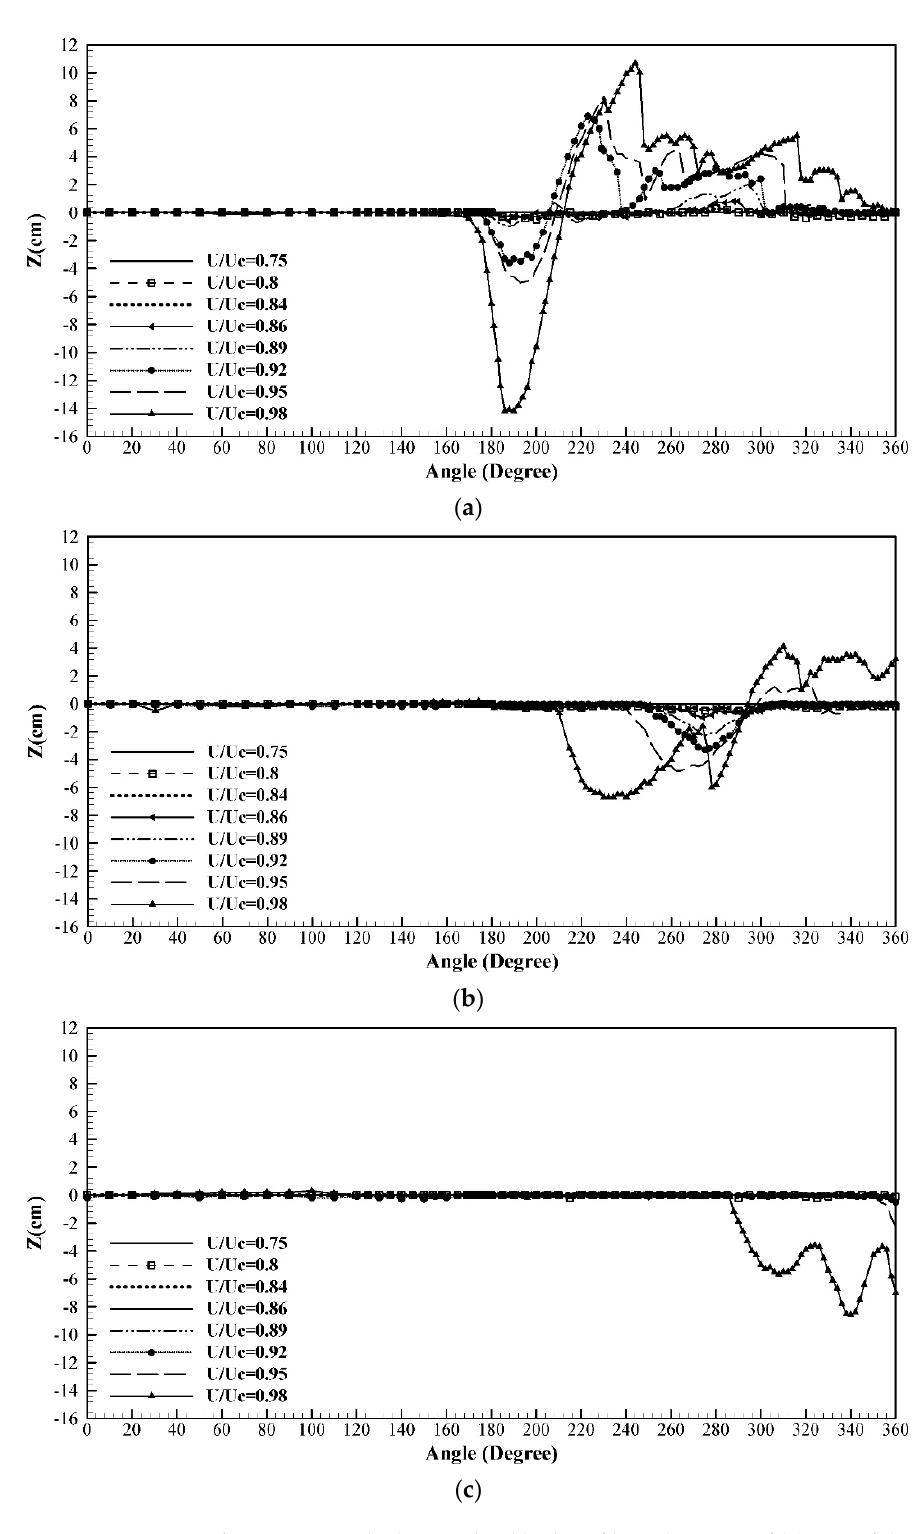
Figure 8. Instances of variations in the longitudinal bed profile at distances of ( a ) 10% of the channel width from the first outer bend and the second inner bend, ( b ) 50% of the channel width, and ( c ) 90% of the channel width from the first inner bend and the second outer bend.